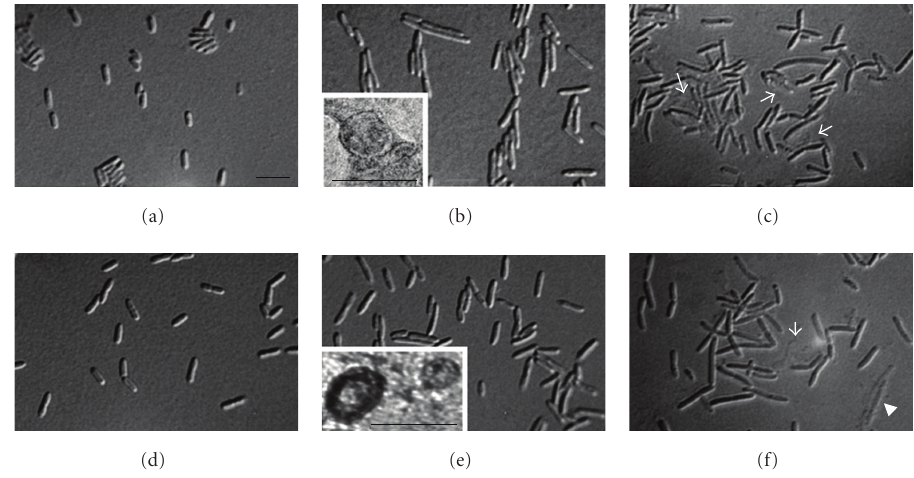
Figure 2: Microscopy of P. aeruginosa under the ciprofloxacininduced SOS response. The wild-type (PAO1) and the LexA noncleavable ( lexAN ) strains were grown in LB with shaking for 2 hrs, and then ciprofloxacin (CPX) was added (1 μ g/mL). The culture continued for 6hrs. (a) PAO1 without and (b) with CPX. (c) PAO1 with 5 μ g/mL CPX. (d) lexAN without and (e) with CPX. (f) lexAN with 5 μ g/mL CPX. Arrows in (c) and (f) show damaged and lysed cells. Cell bar, 5 μ m. Inset (b) shows transmission electron microscopy of OMVs from the treated wild-type cultures. Inset (e) shows lexAN OMVs. OMV bar, 0.1 μ